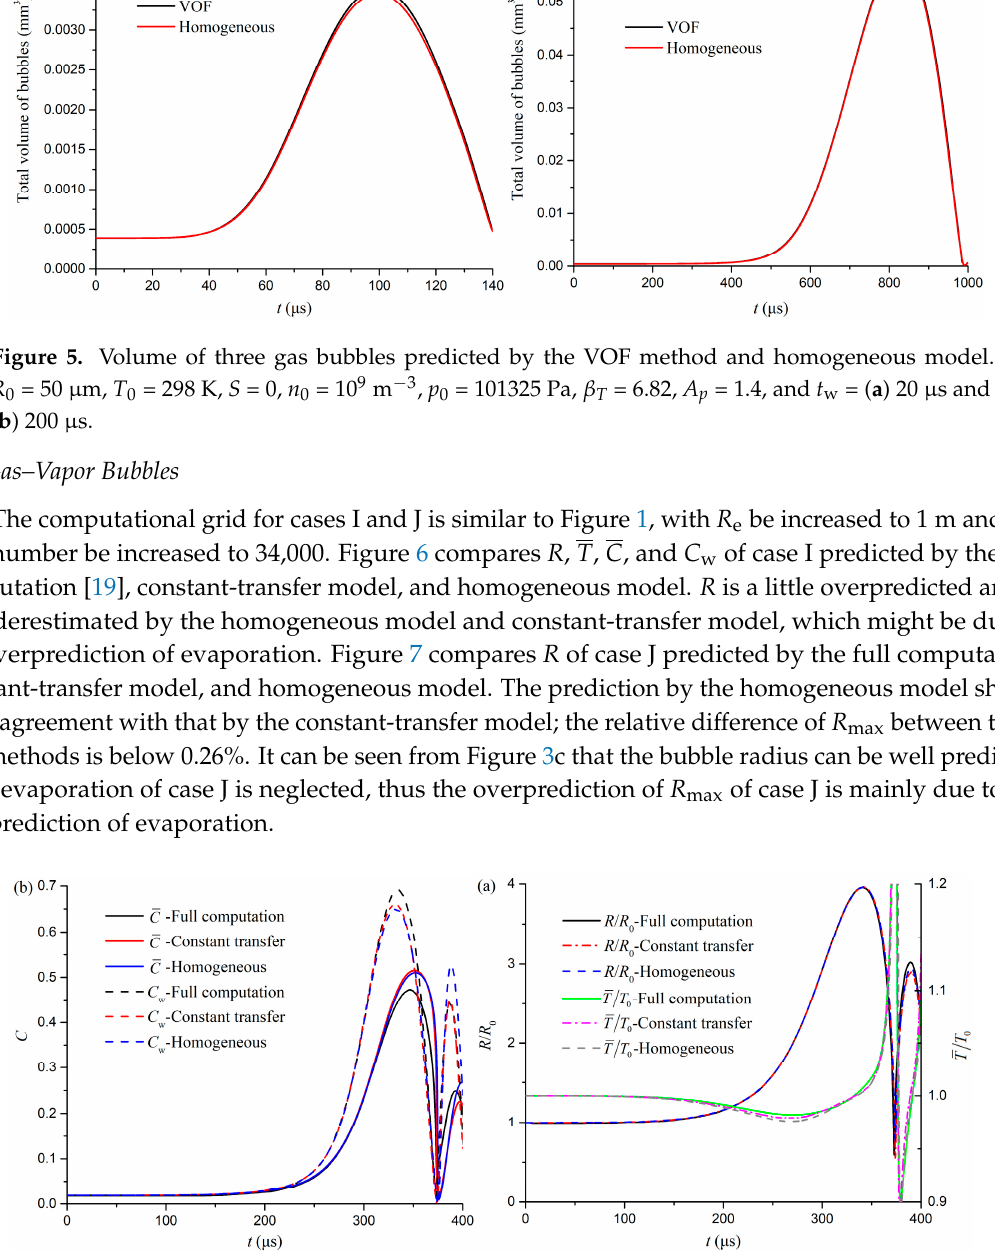
Figure 4. Computational domain and boundary conditions for three gas bubbles.